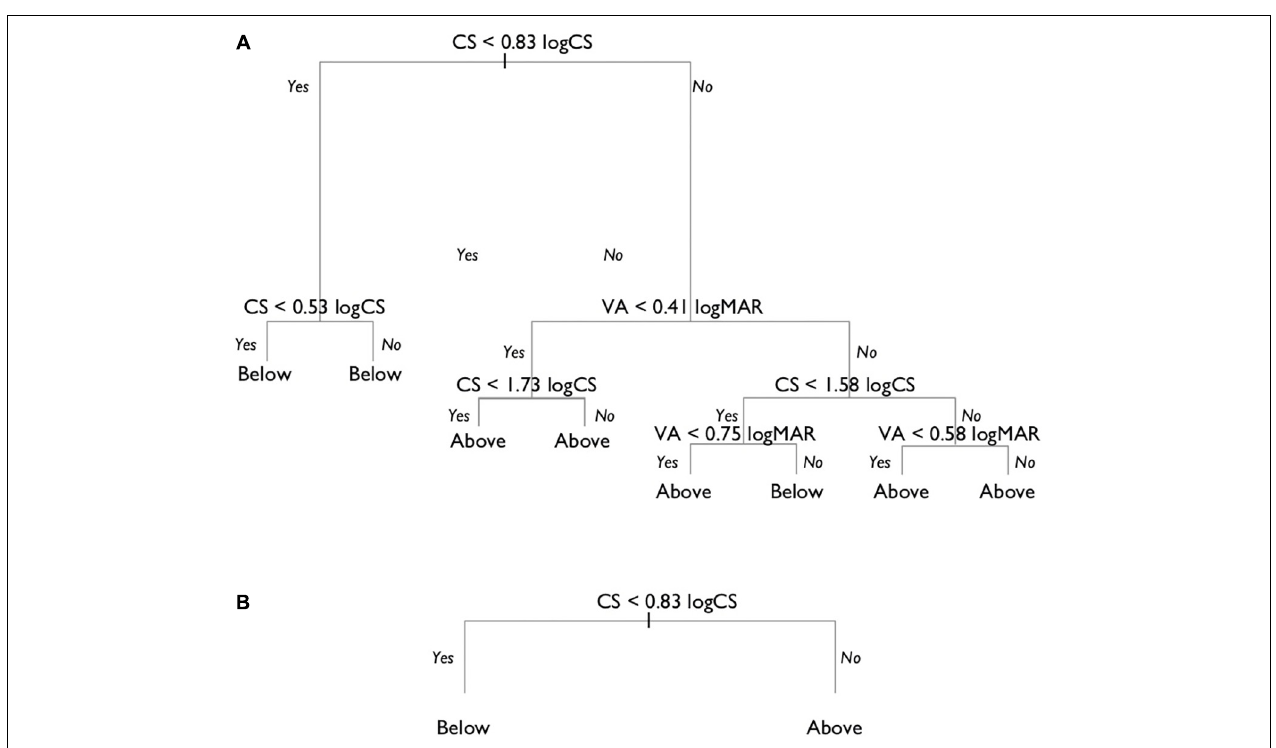
FIGURE 4 | Unconstrained decision tree model. (A) The full decision tree prior to pruning. (B) The pruned decision tree with two final nodes, showing that shooters with a CS poorer than 0.83 logCS were predicted to have below expected shooting scores, and those with better CS have shooting scores within the expected range.